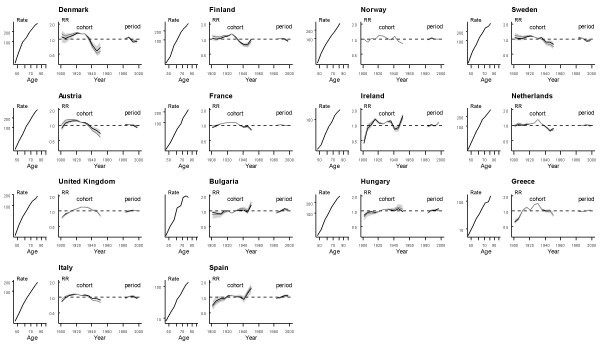
Age, period, and cohort effects on kidney cancer mortality for European women. Age effects are expressed as rates per 1,000,000 person-years, and period and cohort effects as rate ratios (RR) with respect to their average. Osmond-Gardner (black lines) and Decarli-La Vecchia solutions (grey lines) were used to estimate period and cohort effects. The shaded areas are determined by curvatures and exclusive cohort or period slopes. See Methods for further details.